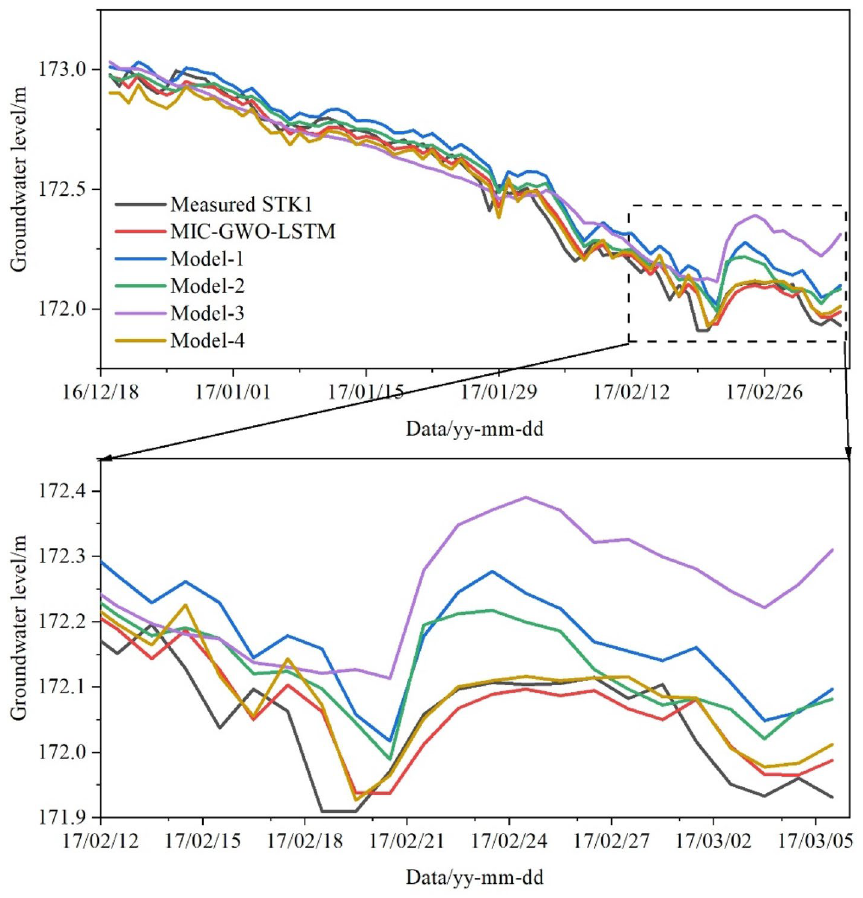
Figure 19. Prediction results under different triggering factors of the validation